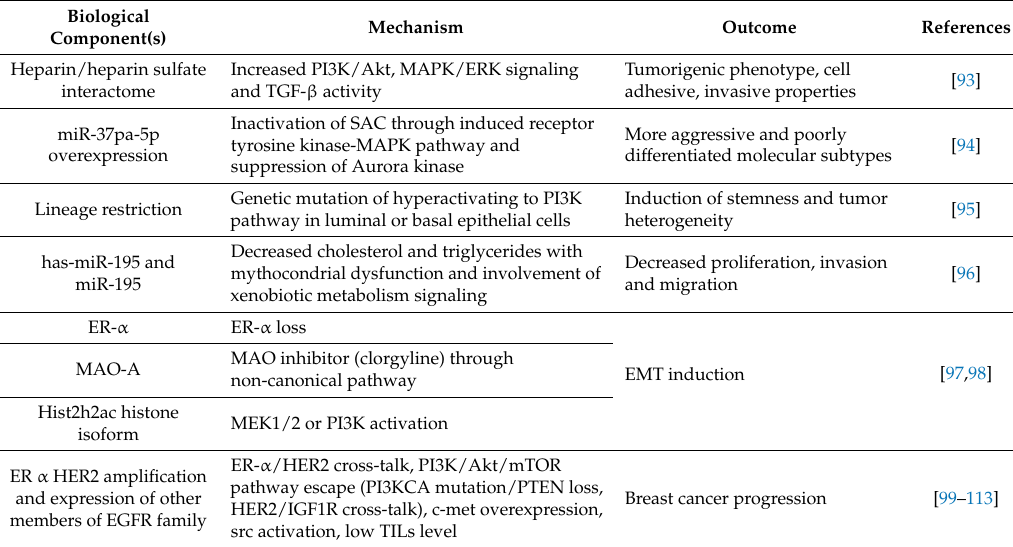
Table 1. Some more specific biological mechanisms and signaling pathways involved in breast cancer